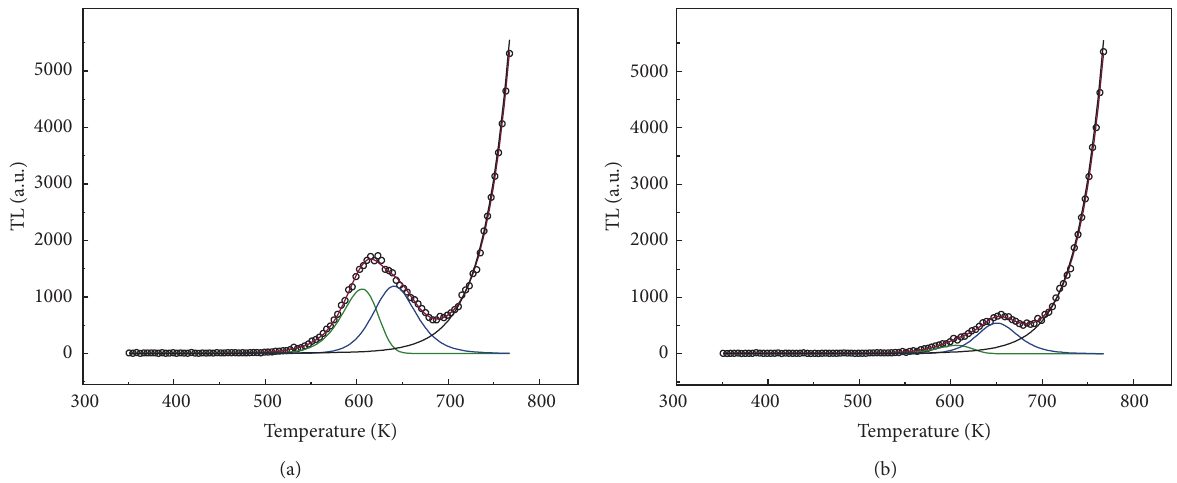
Figure 9: Examples of glow curve deconvolution (GCD) of CaSO 4 :Eu glow curve, as obtained after partial thermal cleaning up to (a) 623 K and (b) 643 K.